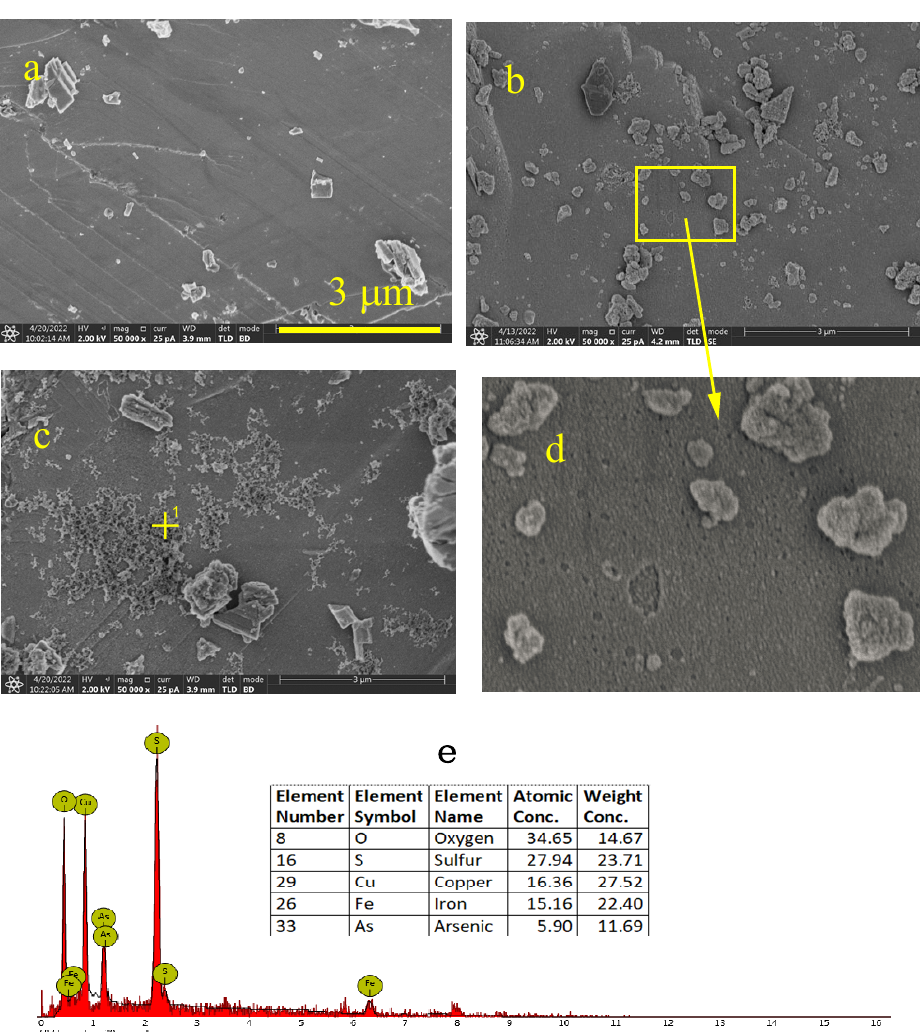
Figure 12. SEM images of the enargite samples: ( a ) fresh sample, ( b ) sample treated with NaClO, ( c ) sample treated with NaClO and FeCl 3 , ( d ) Partial distribution of ( b ), ( e ) EDS result.